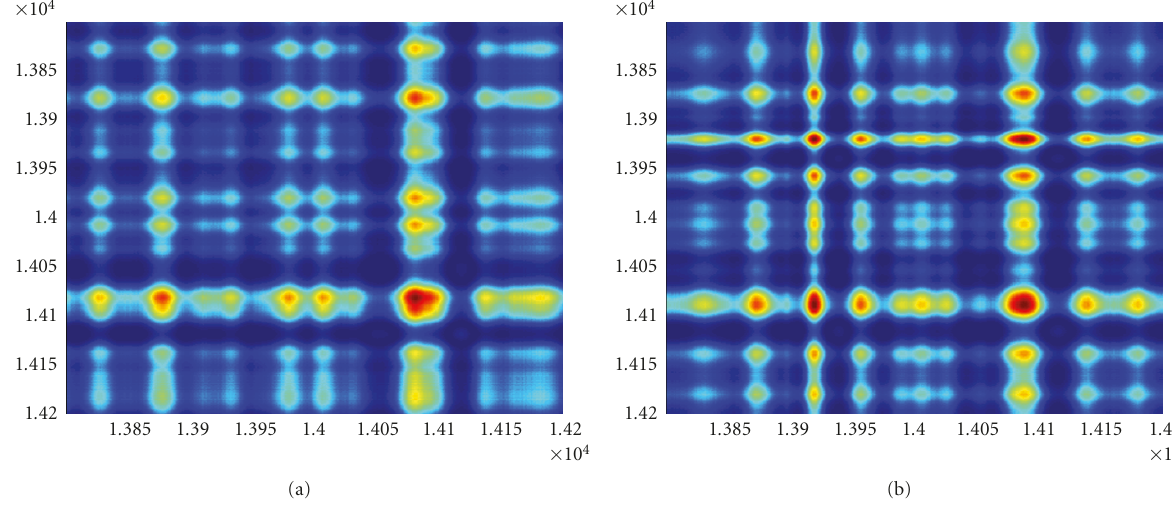
Figure 9: 2-D image created via adding voltages with the appropriate time o ff set. (a) No target (b) With target in the field.